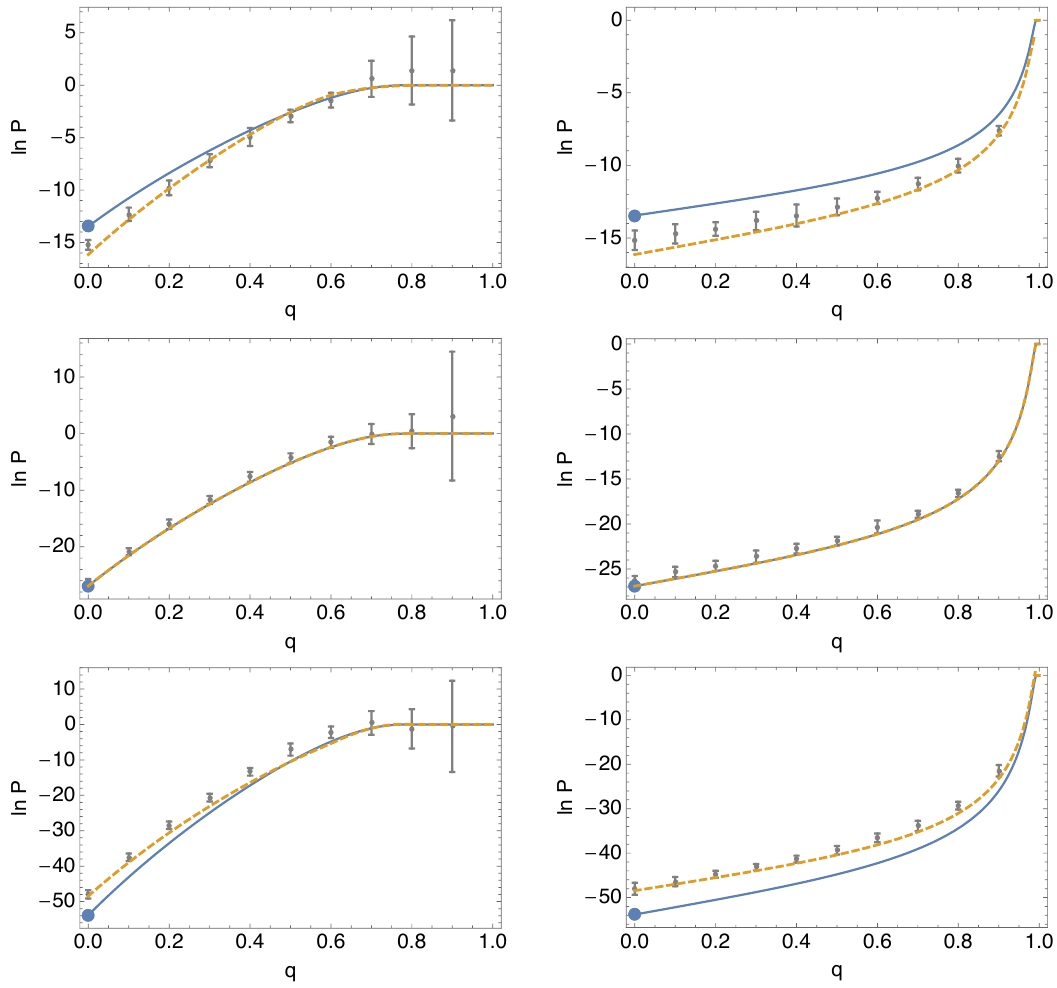
Figure 3 . Fluctuation probabilities for the orthogonal (top), unitary (middle) and symplectic (bottom) ensembles. The plots on the left correspond to (cid:13)uctuation from spectra with (cid:21) i > 1 ; to spectra with (cid:21) i > 0 ; i . The plots on the right correspond to (cid:13)uctuation from spectra with (cid:21) i > 8 1 ; i to spectra with (cid:21) i > 0 ; i . The points with error bars are obtained by numerical integration (cid:0) 8 8 of the pdf, the blue/continuous line denotes the leading N 2 approximation, the yellow/dashed line includes the subleading ( N ) corrections to the Hamiltonian. The blue circles represent the Dean O and Majumdar’s result for the static ensembles. We set a = 2 for all